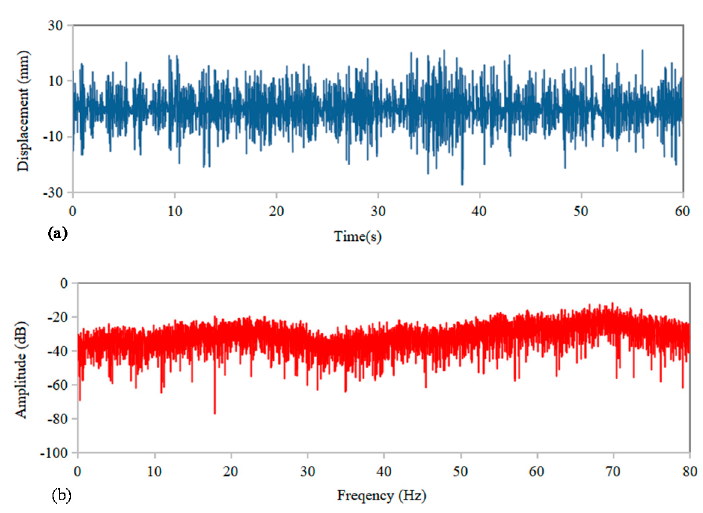
Figure 6. The time series displacement of random signal and its frequency component distribution. ( a ) Vibration displacement. ( b ) Power spectrum.